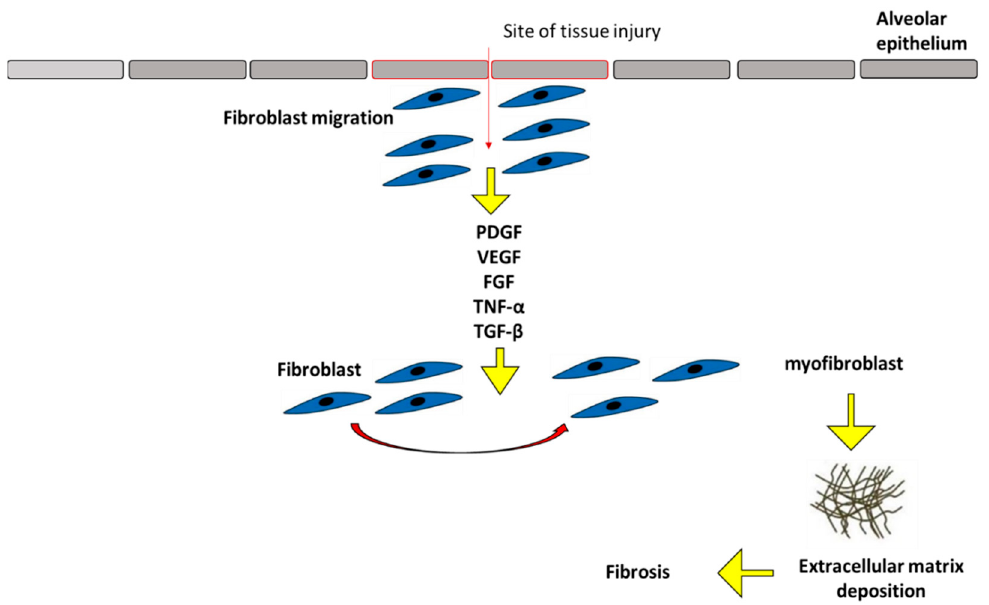
Figure 1. The major mechanisms of fibrosis. PDGF: Platelet-derived growth factor; VEGF: Vascular endothelial growth factor; FGF: Fibroblast growth factor; TNF- α Tumor necrosis factor-alpha; TGF- β : Transforming growth factor beta.